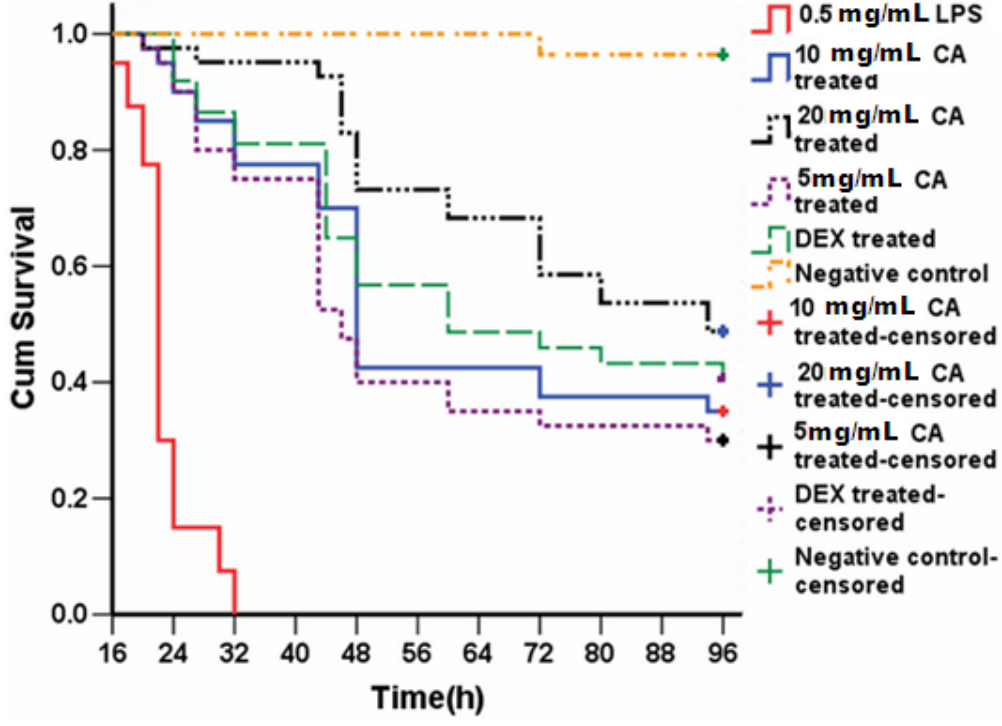
Figure 12. Protective effect of CA (20 mg/mL) on 3-dpf zebrafish larvae challenged with LPS. Three-hundred larvae were randomly divided into six groups ( n = 50). The yolks of larvae were injected with 0.5 mg/mL LPS at 3-dpf and treated with the indicated doses of CA. Mortality was monitored for 96 h. Negative controls were injected with PBS. Each curve represents data pooled from three independent